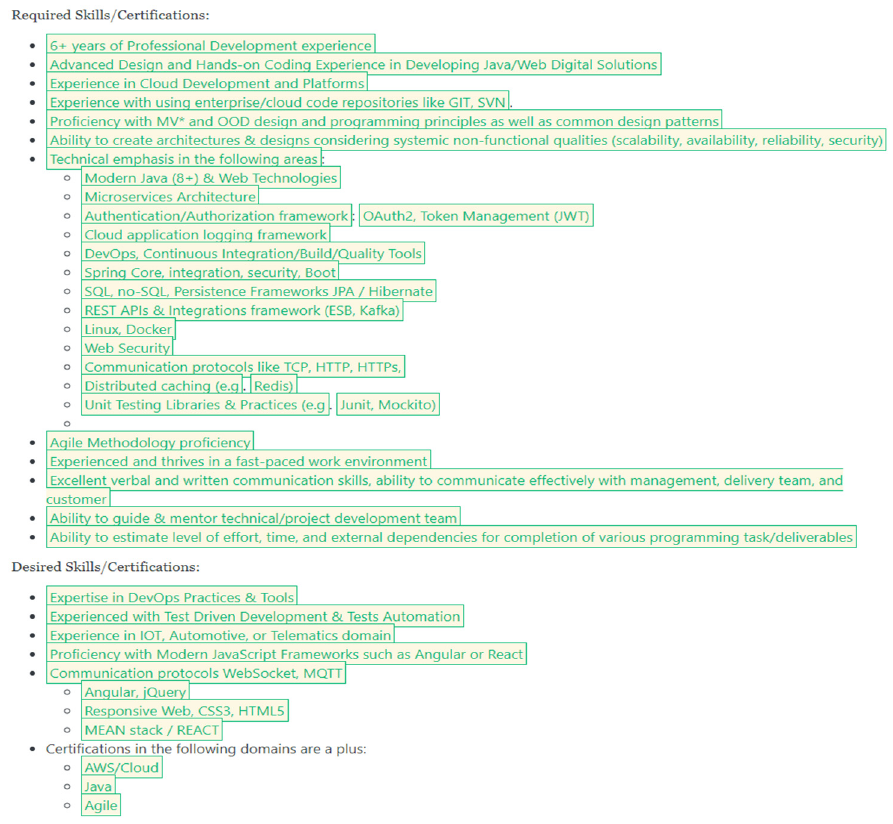
Figure 15. Part of a job advertisement processed by the method called machine learning with improved marking lists.